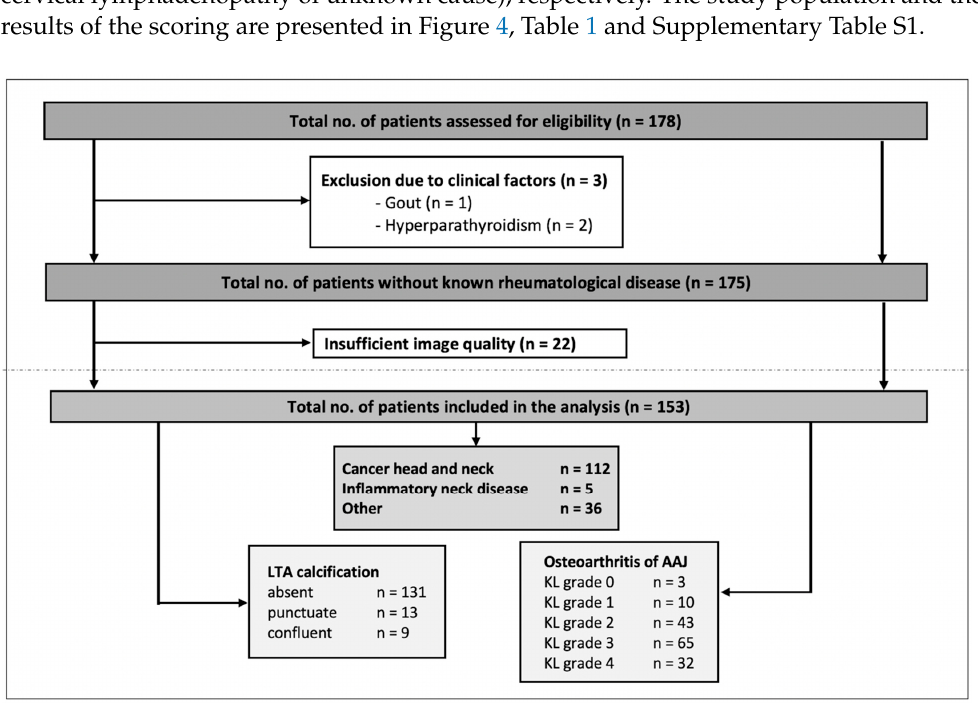
Figure 4. Flowchart of the study inclusion and results of the scoring. LTA = ligamentum transversum atlantis, AAJ = atlantoaxial joint, KL = Kellgren and Lawrence grading. Table 1. Characteristics of the study population.